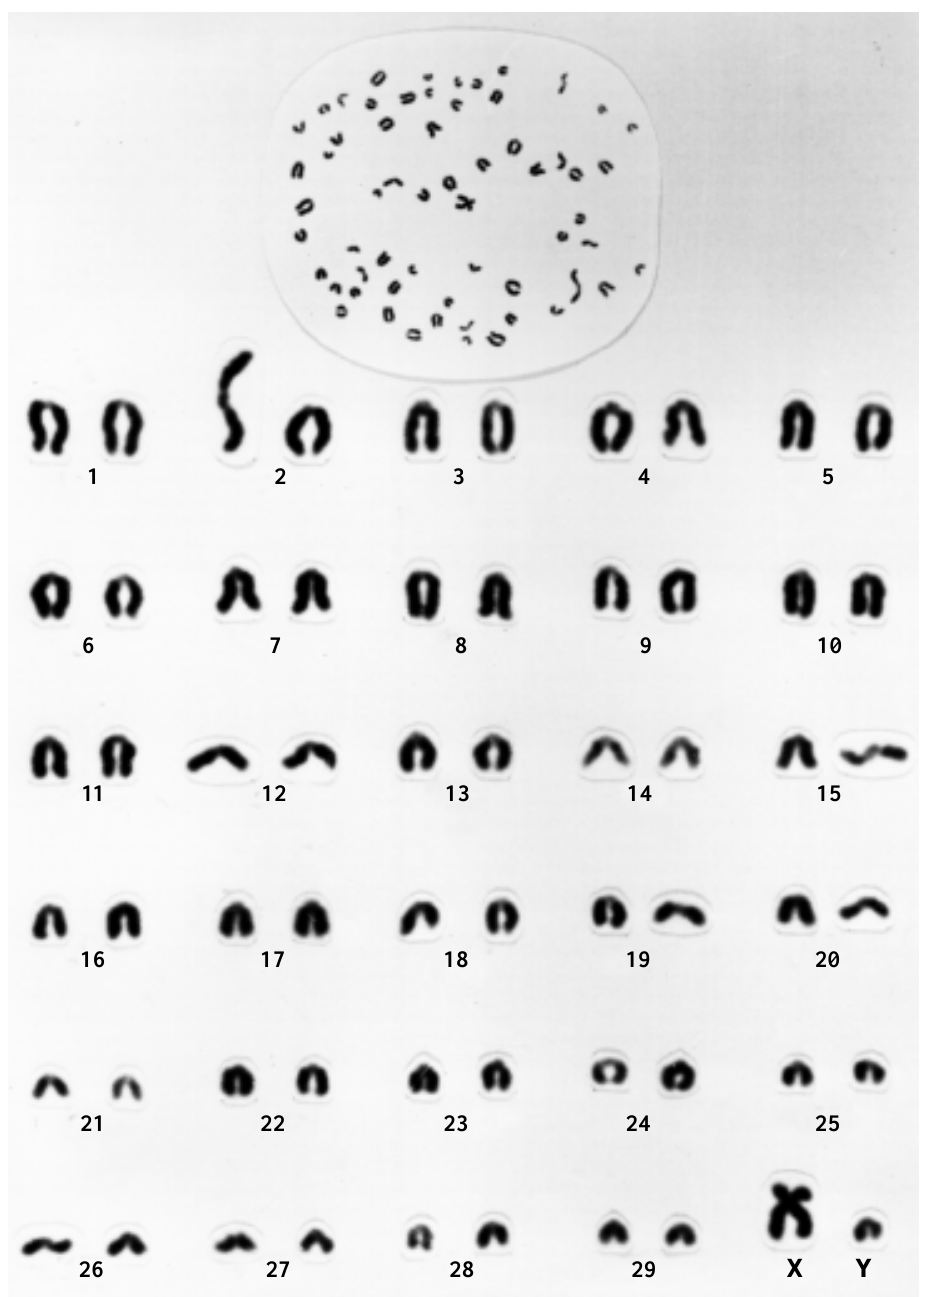
Figure 2 - Acrocentric Y chromosome-bearing karyotype of a “pé-duro” bull (2n = 60,